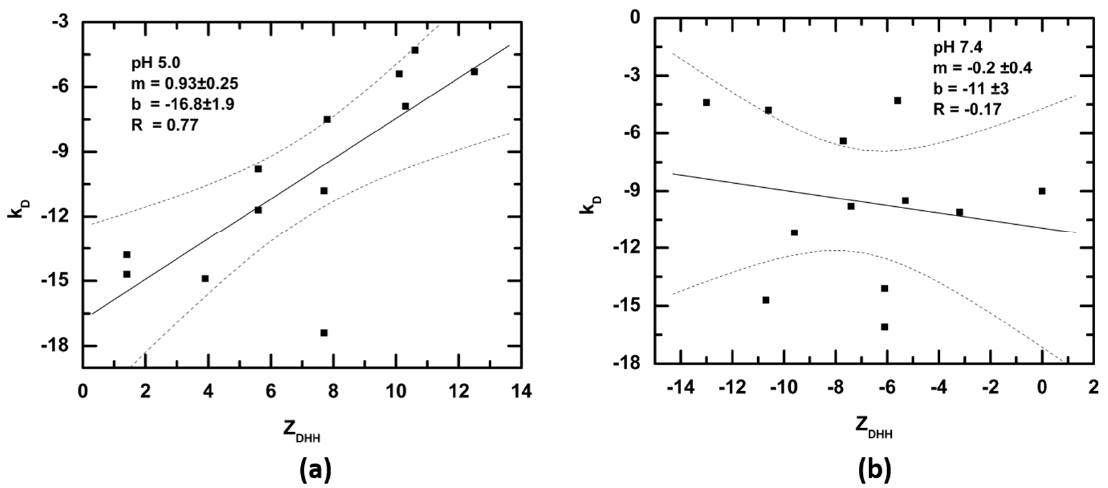
Figure 8. Linear regression analysis and correlation between Z DHH measured for intact IgG and the concentration-dependence of the diffusion coefficient, k D . ( a ) pH 5.0, acetate buffer, ( b ) pH 7.4 PBS. Dotted lines indicate the 95% confidence interval.